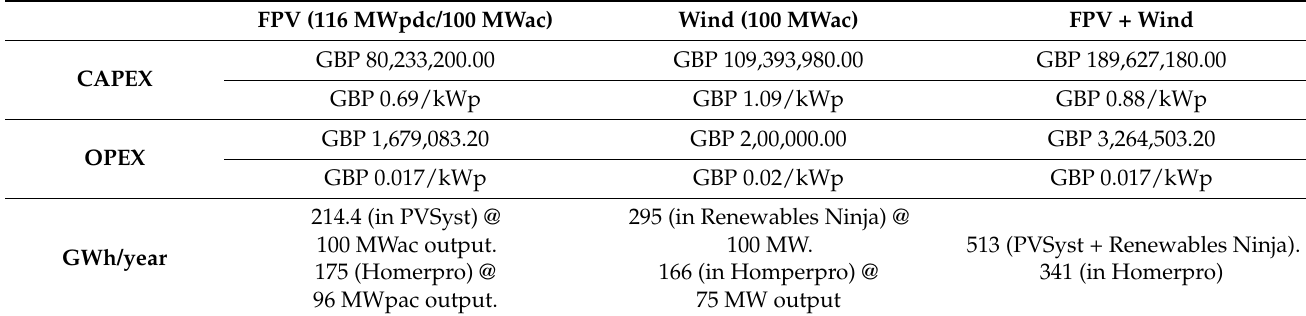
Table 5. Table showing the cost and energy production distribution (cost breakdown sources